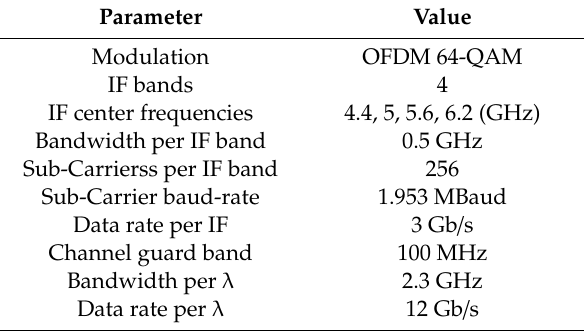
Table 1. Format parameters of the multi-intermediate-frequency (IF) band